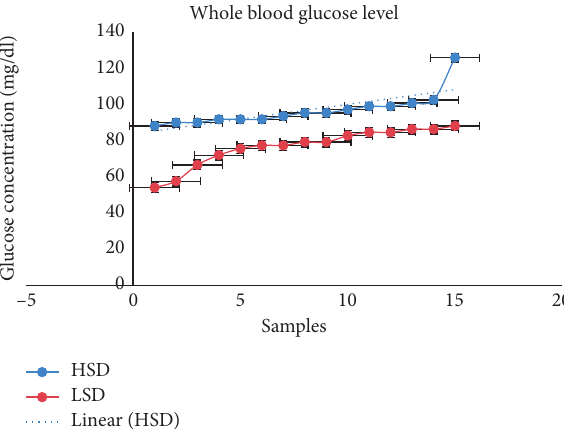
Figure 3: Glucose concentrations in Low Stocking Density- (LSD-) and High Stocking Density- (HSD-) reared O. niloticus